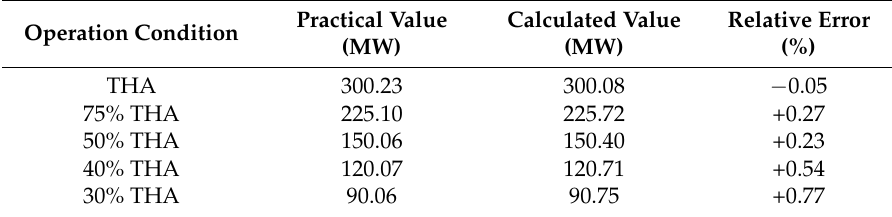
Table 3. Relative error of the calculated unit generation power by the simulation model under different operation conditions. THA—turbine heat acceptance; MW—heat.